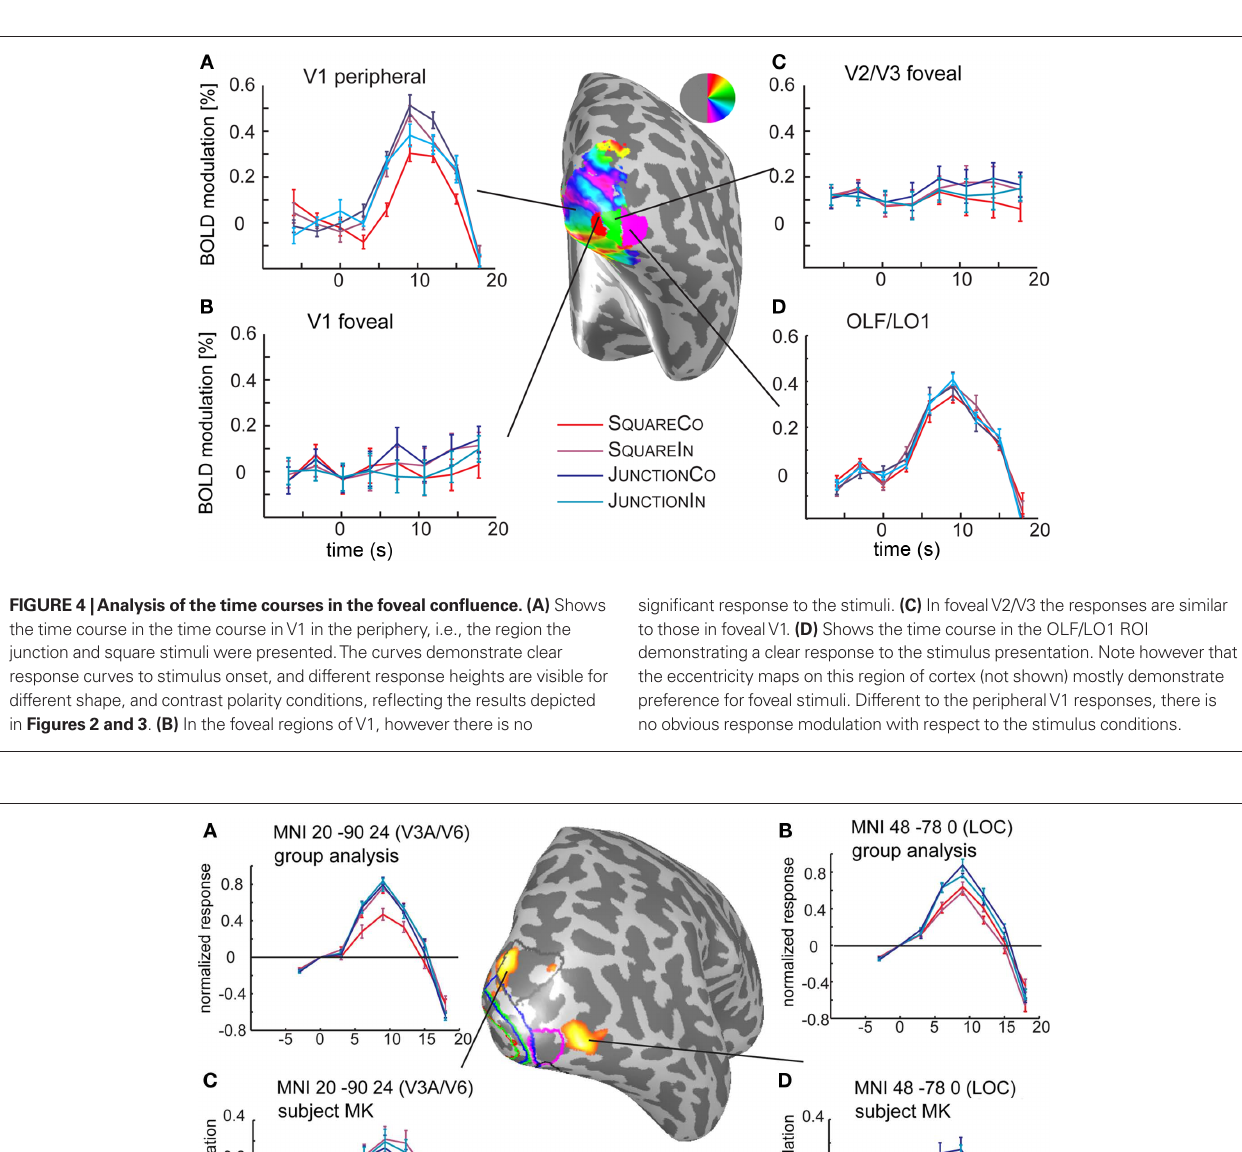
FIguRE 5 | Time courses and locations of the SPM-group analysis. The results of the SPM test are projected in red on the right hemisphere of subject MK. The top plots (A,B) depict the time courses from the group analysis, the bottom plots (C,D) depicts the same coordinates (by the means of an inverse normalization) in a single subject. Marked on the